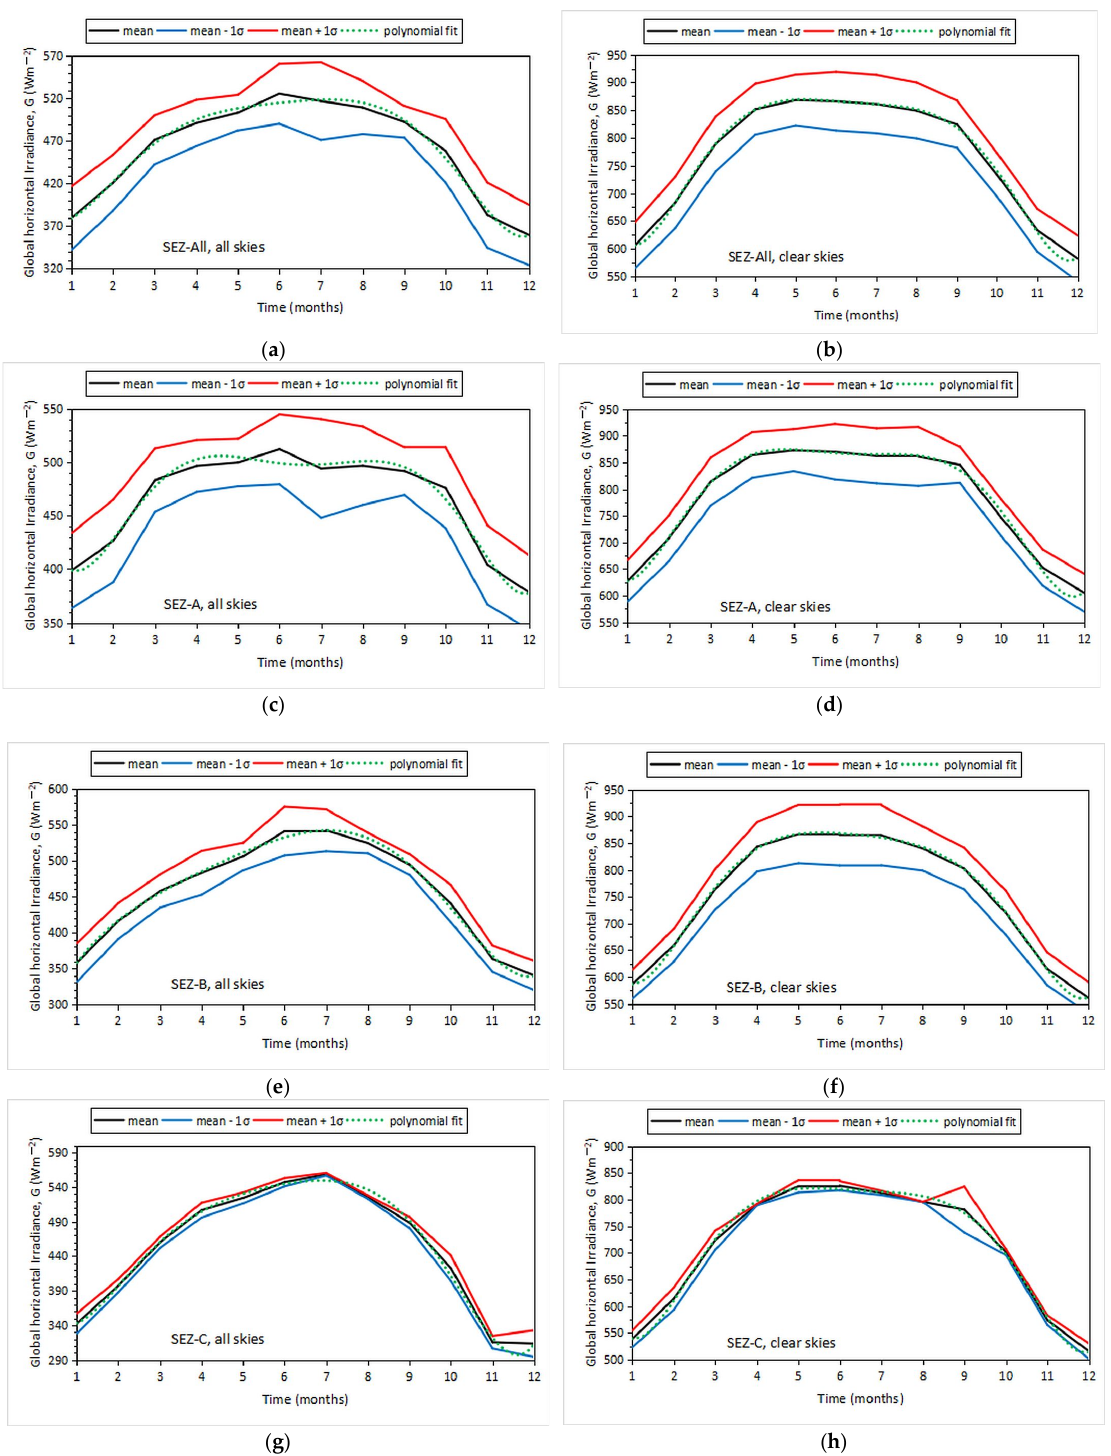
Figure 4. Monthly mean G values under all—(left panels) and clear—(right panels) sky conditions across Saudi Arabia in the period 2013–2021 ( a – h ). The first row is the SEZ-All case, the second is SEZ-A, the third is SEZ-B, and the last row is SEZ-C. The G values are averages across the sites belonging to each SEZ and over the studied period. The black lines represent the means; the red and blue lines are the upper and lower limits of the ±1 σ band around the means, respectively. The green do tt ed lines are 6th-order polynomial fi ts to the mean curves. The numbers on the x-axis are the months from January = 1 to December = 12. All plots were derived with the MICROSOFT’s Excel 2021 utilities. Table 2. Estimation of the monthly mean values of G (Wm − 2 ) and G d (Wm − 2 ), which are averages over the period 2013–2021, for all 43 sites in SEZ-All, or those sites that belong to the separate zones SEZ-A, SEZ-B, and SEZ-C. t is month (1 = January, 12 = December); statistical estimators for the model’s goodness-of- fi t: RMSE (Wm − 2 ), MAE (Wm − 2 ), d, r, and R 2 . All statistical results were com-